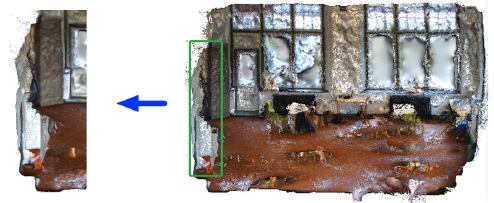
Figure 11. The area with green rectangle in the mesh model is a locker, which is a concave space from the bottom